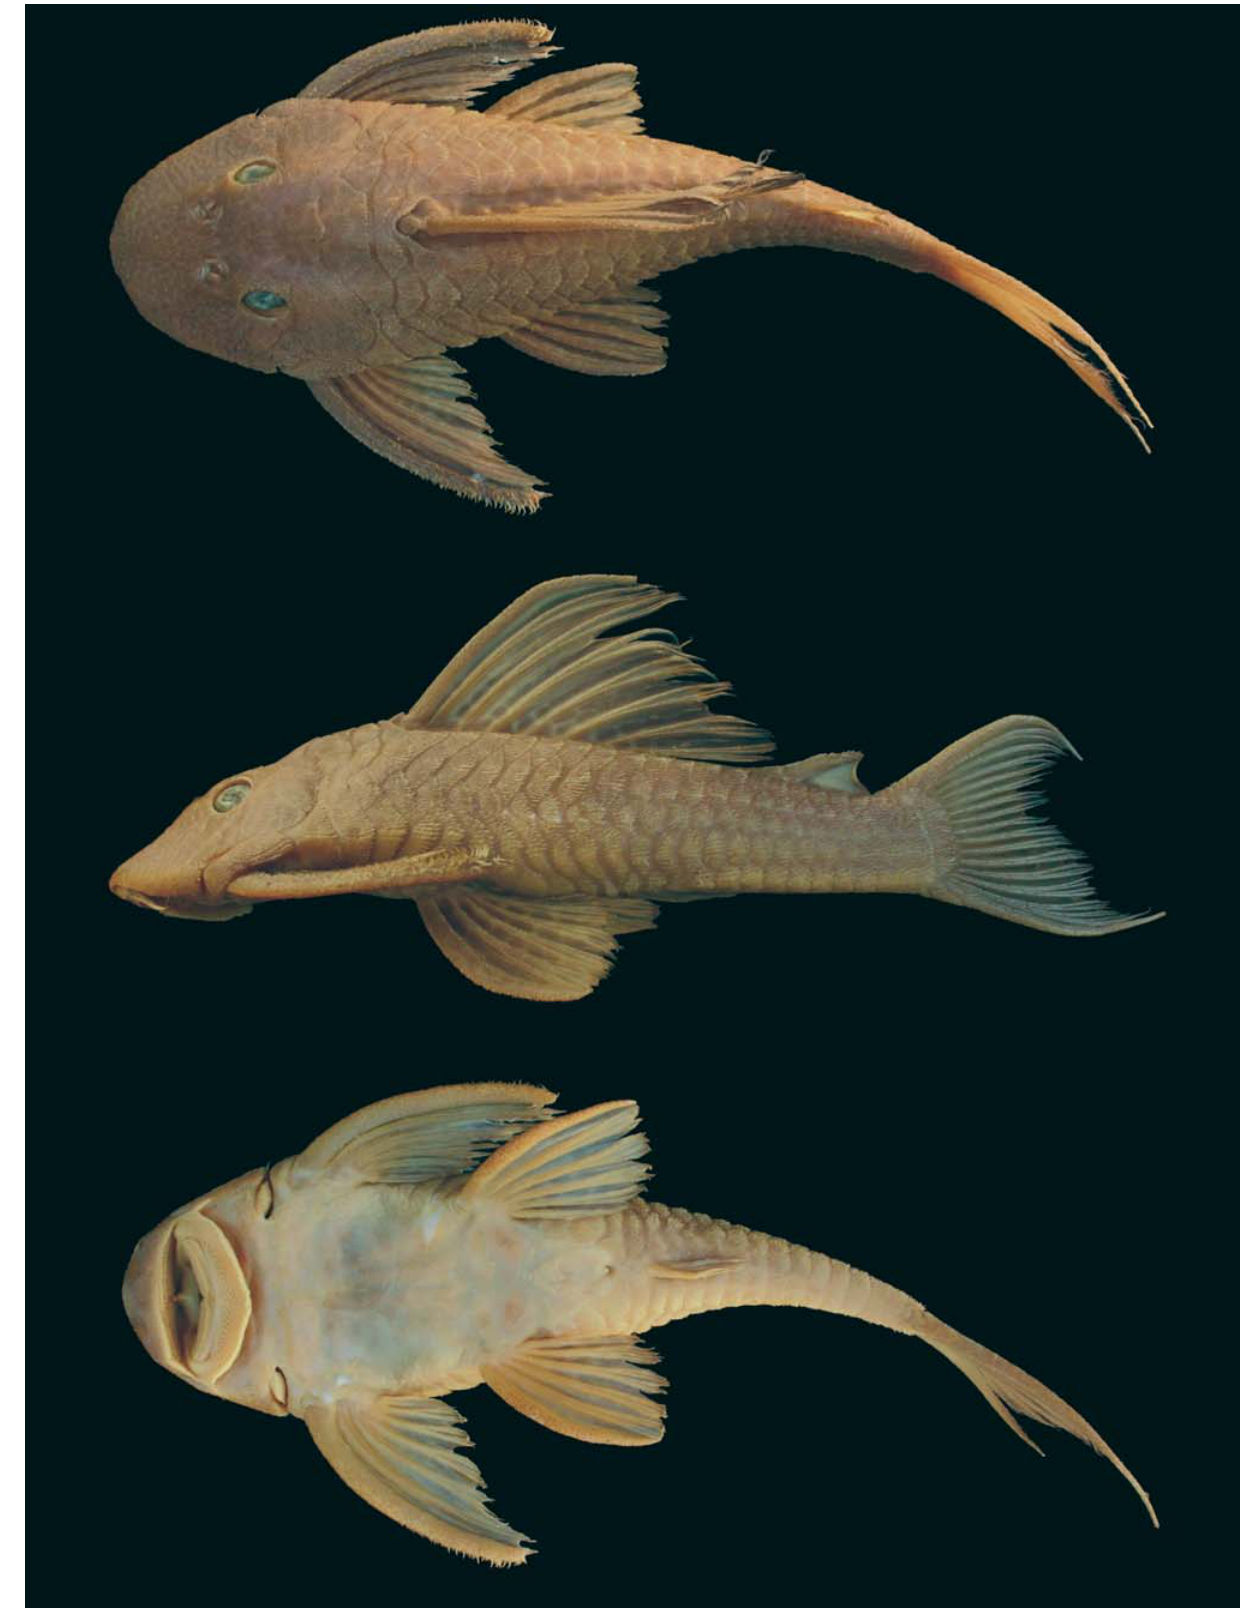
Fig. 1. Hypostomus denticulatus , holotype, Brazil, Goiás state, Município de Caldas Novas, rio do Peixe, tributary to rio Corumbá, MZUSP 98770, 161.9 mm SL. Dorsal, lateral, and ventral